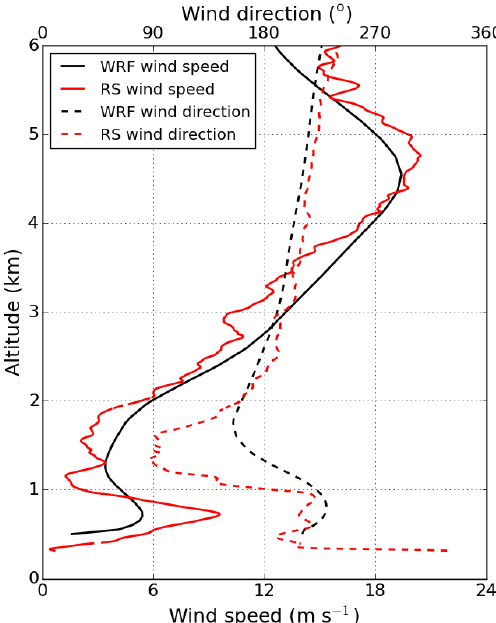
Figure B1. Wind speed and wind direction up to 6km as an aver- age from 03:00 to 03:30UTC from WRF simulations (black lines) and from the radiosonde (RS, red lines) launched at 02:55UTC on 14 June